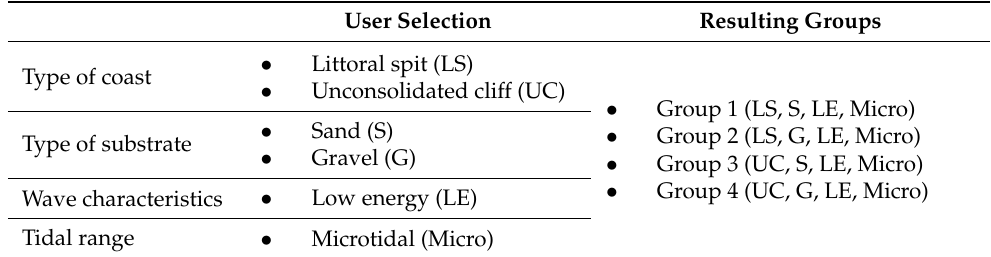
Figure 3. CDMIA procedure for the grouping of environmental features. Table 7. Example grouping of environmental features according to a hypothetical user selection.